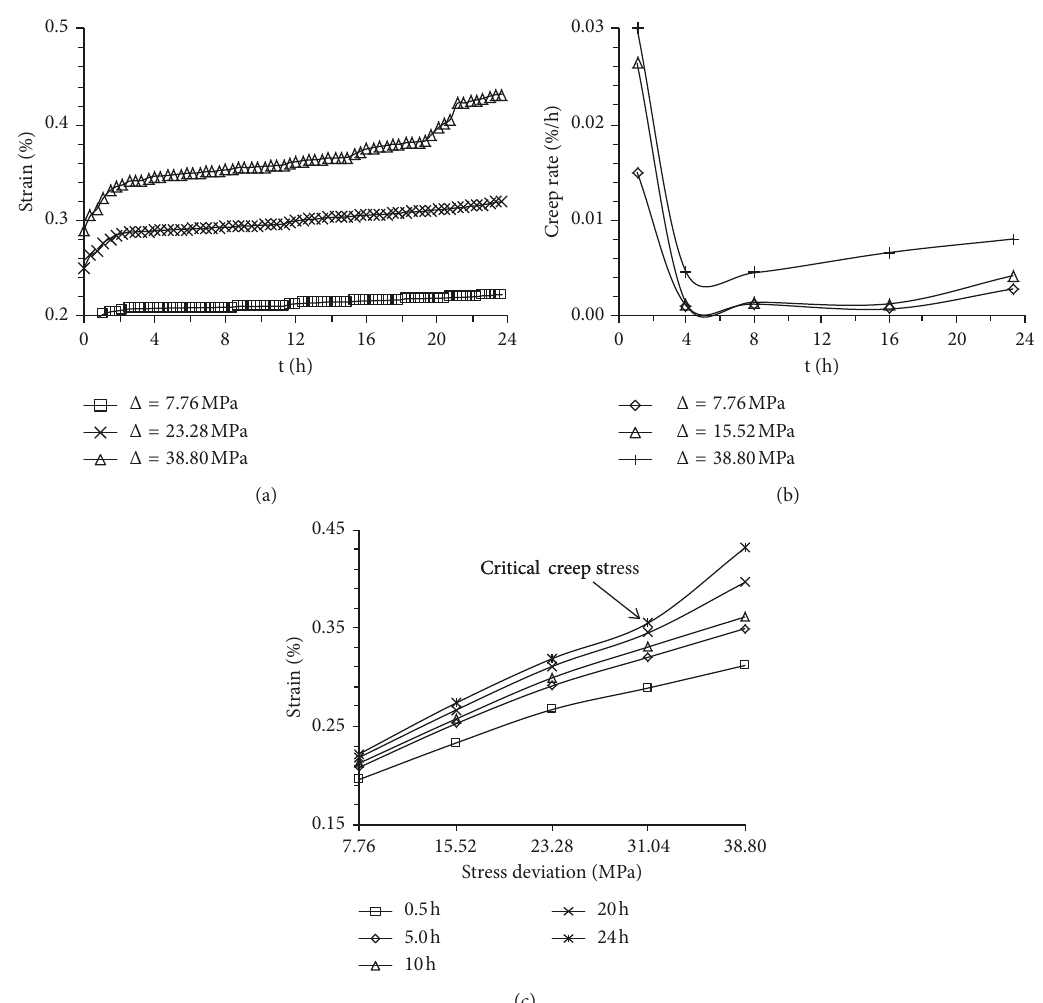
Figure 3: Influence of different stress deviations on creep properties of shale (pH curves. (c) Isochronous stress deviation-strain curves. Table 3: Creep parameters of deep shale at pH Stress deviation (MPa)